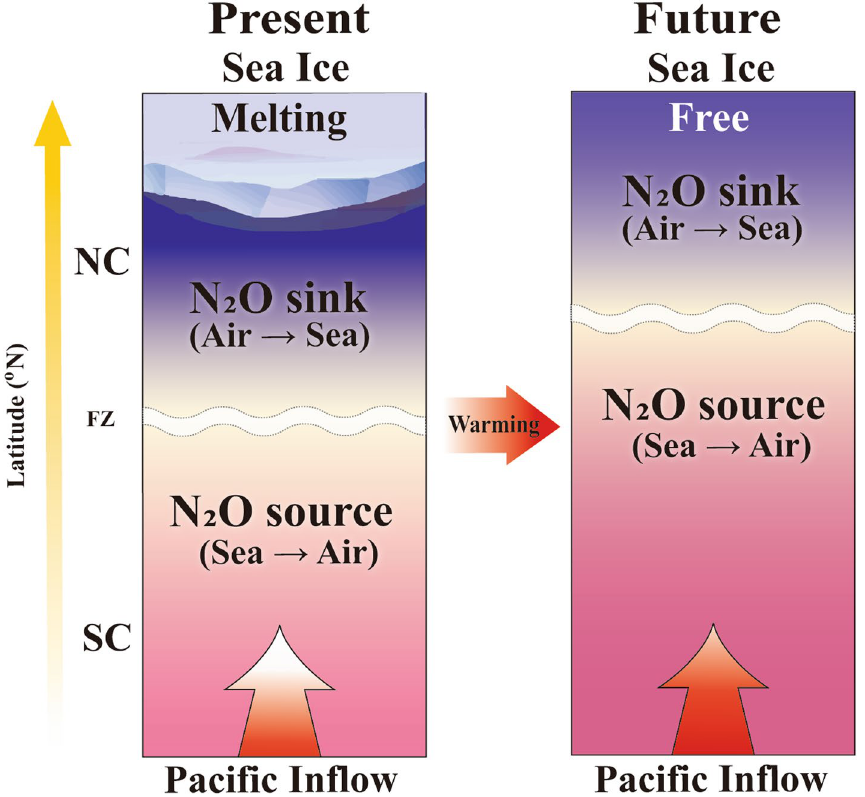
Figure 4. Illustration showing future changes in the distribution of the WAO N 2 O flux constrained by the positive feedback scenario of increasing inflow of Pacific waters and rapidly declining sea-ice extent under accelerating Arctic warming. Note that this figure was generated using Adobe Illustrator CC program (ver. 2018 and www. adobe.